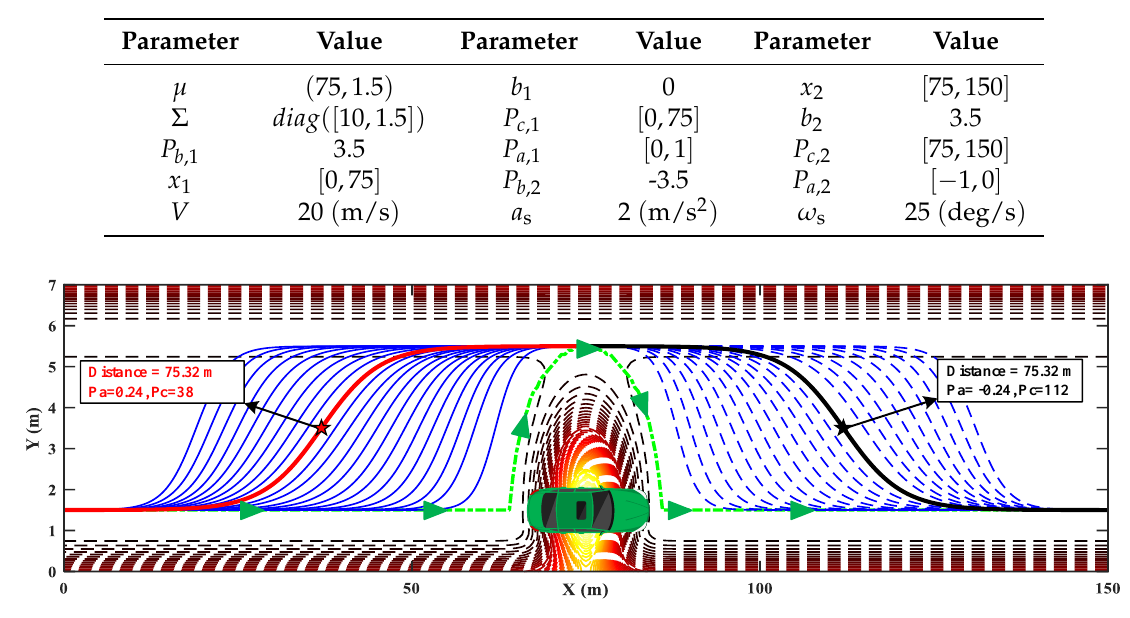
Table 2. Initialization parameters.